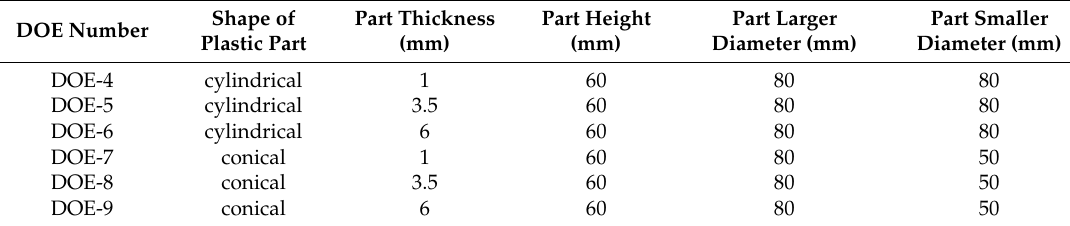
Figure 1. CAD models of six different plastic parts. Table 4. Plastic part dimensions for DOE 4, 5, 6, 7, 8 and 9.